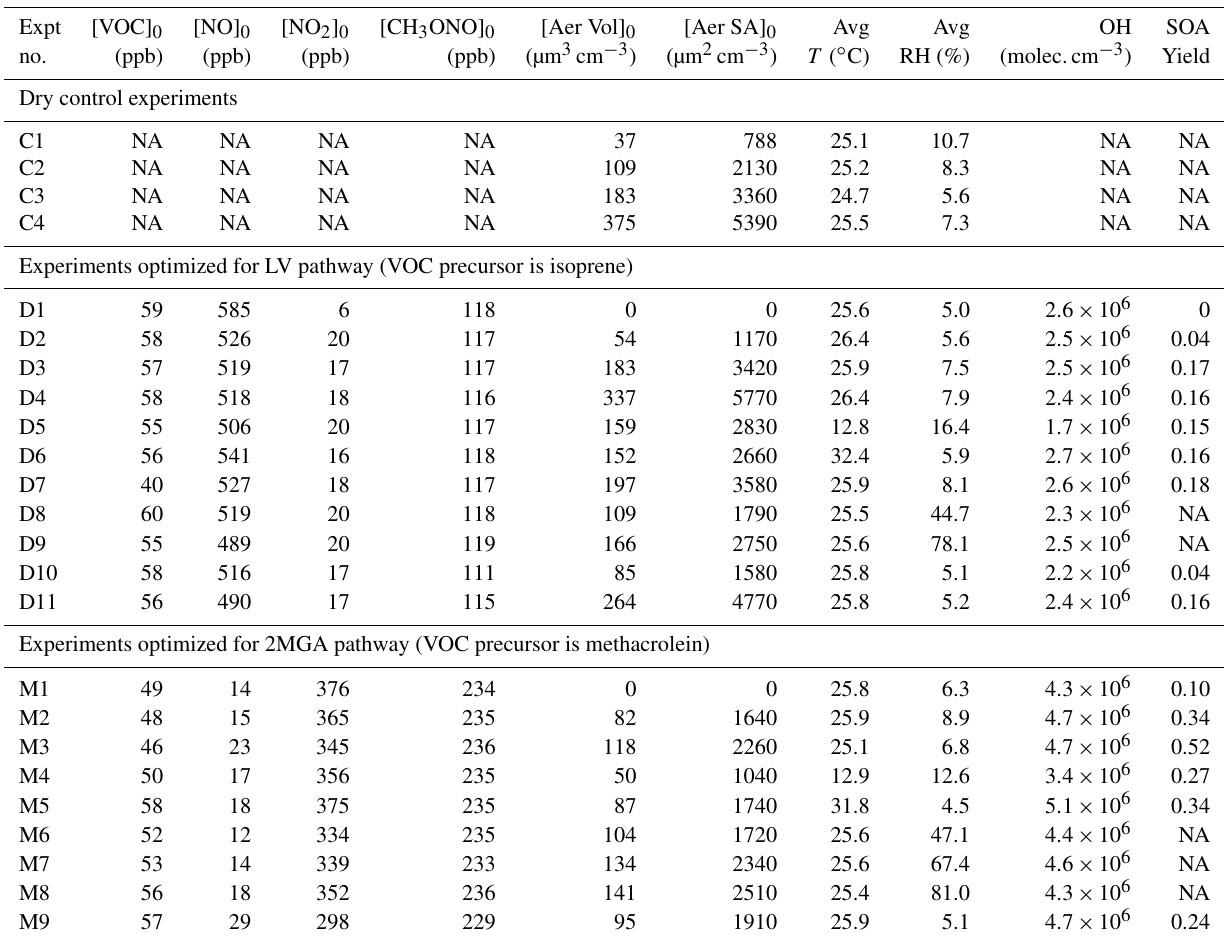
Table 1. Initial conditions and SOA yield for all